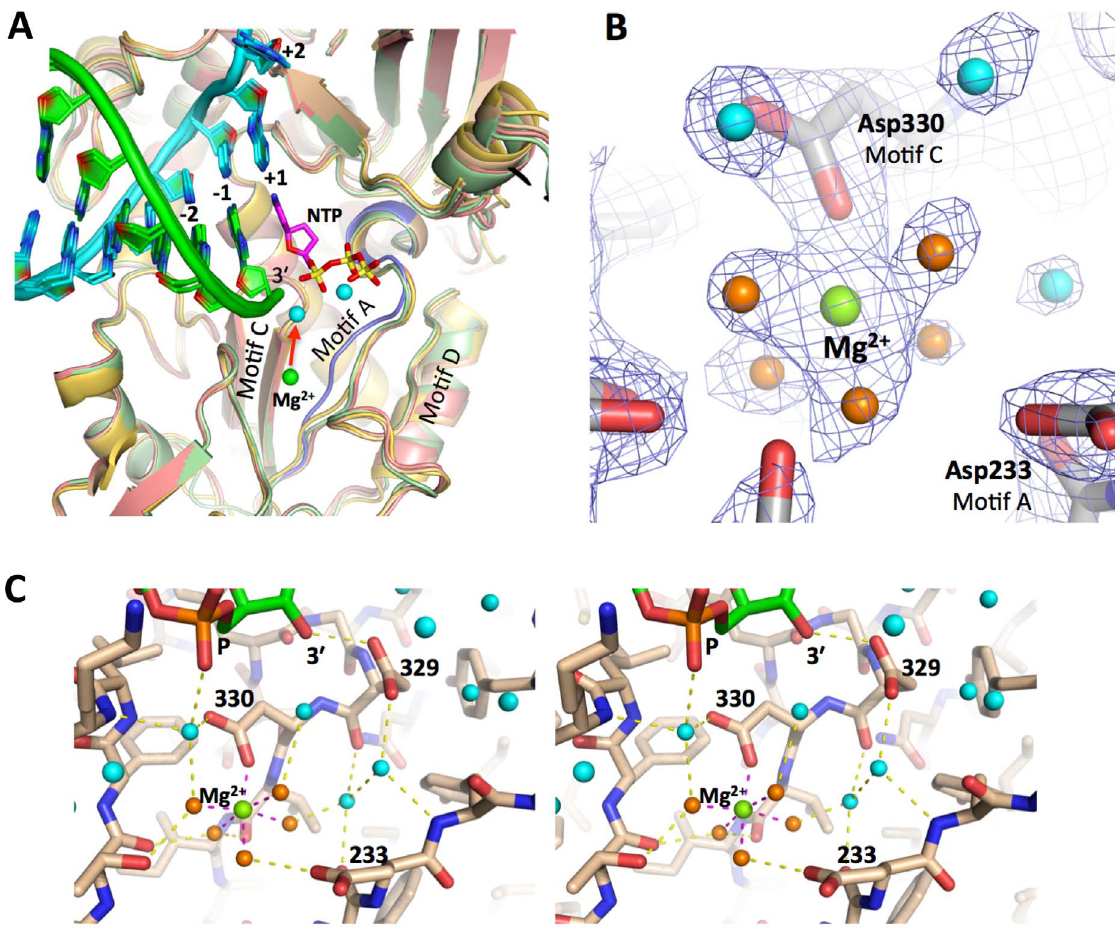
Figure 8. Motif A conformation and polymerase bound Mg 2 + ion. A) Composite overview of the picornaviral polymerase active site based on a combination of superimposed structures to show the conformation of key conserve sequence motifs-A, -C, and -D involved in catalysis, a bound ddCTP (magenta) from the prior state 2 structure (PDB code 3OLB), and the positions of the catalytic magnesium ions before and during catalysis (green and cyan spheres). The structures presented in this paper (PV in red, CV in green, RV in gold) were all solved in the open conformation active site where motif A does not fully participate in the b -sheet with motif C, as shown by the comparison with the closed conformation of motif A (blue) seen in the prior state 4 structure (PDB code 3OL7). The CV_r2_Mg structure showed a magnesium ion (green sphere) pre-bound to the polymerase in a site 5.3 A˚ away from its position in the closed active site complex where it is joined by a second magnesium form the NTP-Mg complex (cyan spheres, from 3OL7). B) Electron density for the pre-bound magnesium ion coordinated by Asp330 and five water molecules (orange) in the CV_r2_Mg structure. Data is a 2F o -F c electron density map contoured at 1.7 s and Mg 2 + –O coordination distances are 2.0–2.2 A˚. C) Stereo pair images of the Mg 2 + coordination geometry and neighboring residues, including the RNA 3 9 hydroxyl group, the active site Asp329 residue, and Asp233 from motif A that swings toward the active site to directly coordinate the magnesium in the closed conformation.